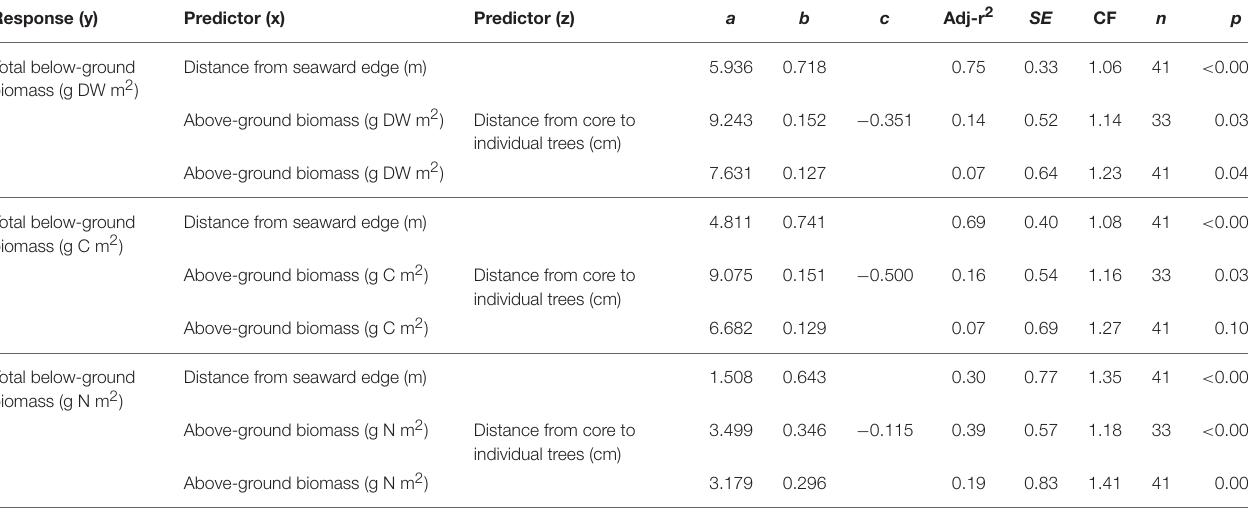
TABLE 3 | Allometric equations for temperate Avicennia marina subsp. australasica below-ground biomass, carbon and nitrogen stocks to 100cm depth. Response (y) Predictor (x)